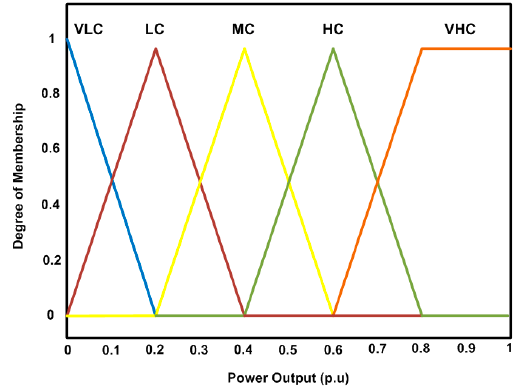
Figure 3. Fuzzy logic output.